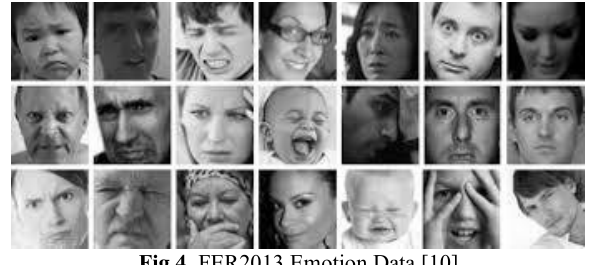
Fig 4. FER2013 Emotion Data